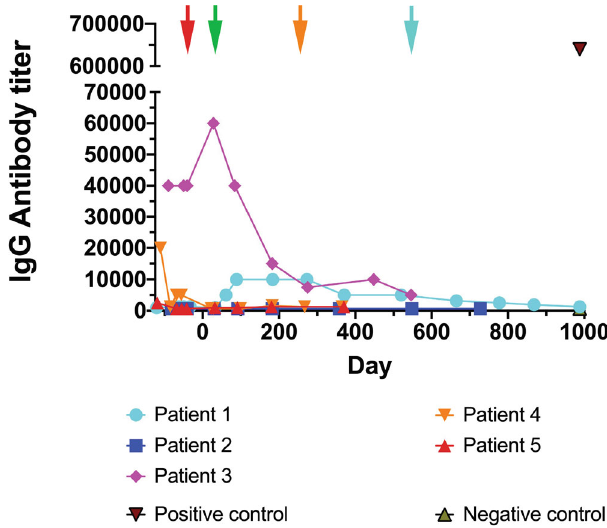
Fig. 5 Immunoglobulin G (IgG) antibody titer.